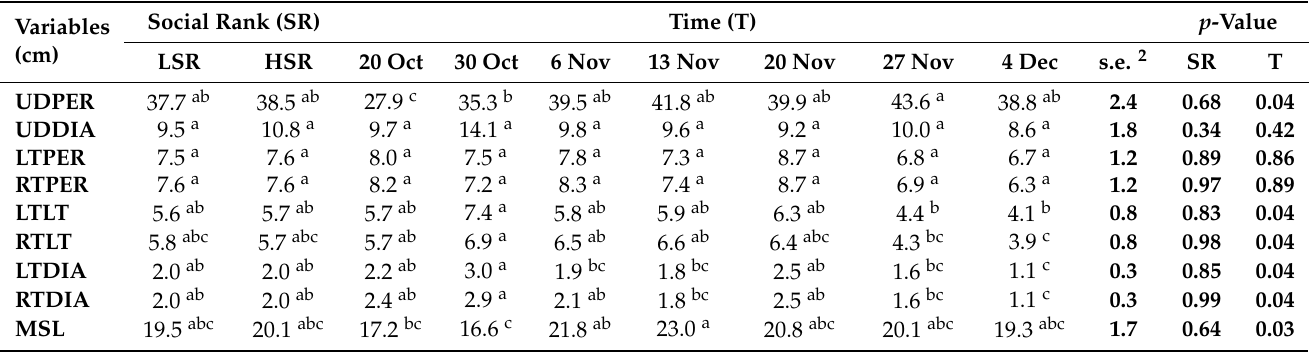
Table 2. Least-square means ± s.e. for goat udder morphometric components considering udder perimeter (UDPER, cm), udder diameter (UDDIA, cm), left-teat perimeter (LTPER, cm), right-teat perimeter (RTPER, cm), left-teat length (LTLT, cm), right-teat length (RTLT, cm), left-teat length diameter (LTDIA, cm), right-teat diameter (RTDIA, cm), and medium suspensory ligament (MSL, cm) as affected by either social rank (i.e., LSR and HSR) and time (i.e., 7 times) in crossbred